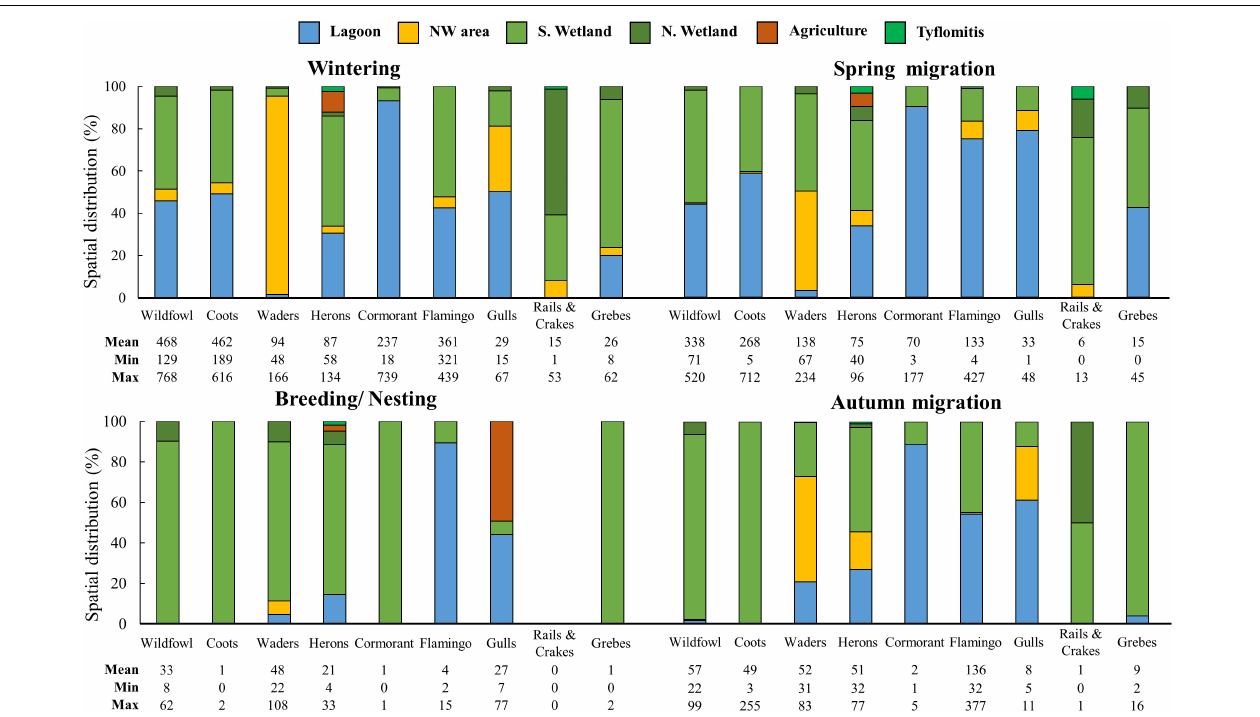
FIGURE 4 | Stacked column graph showing the spatial distribution (percentage) of waterbirds’ categories in the different sub-areas of the GLw-Natura2000 area, based on their average population distribution during the different periods. The abundance (mean, minimum and maximum values) of each waterbirds category during the same period is presented in the table at the bottom of each